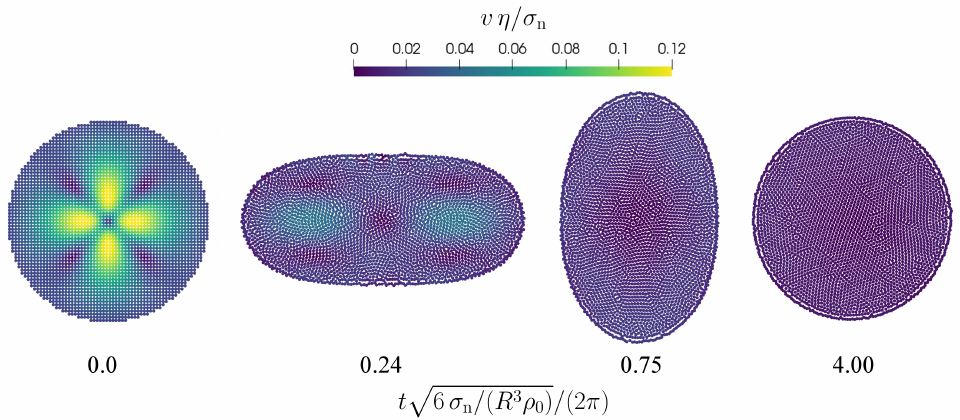
Figure 1. Oscillation of a free droplet with a divergence-free initial velocity field. The normalized velocity magnitude is color-coded. The time is normalized by the oscillation frequency (Equation (52)). The lateral expansion L x of the droplet as a function of time is shown in Figure 2. The regular oscillation with decay in amplitude due to viscous dissipation is clearly perceptible.